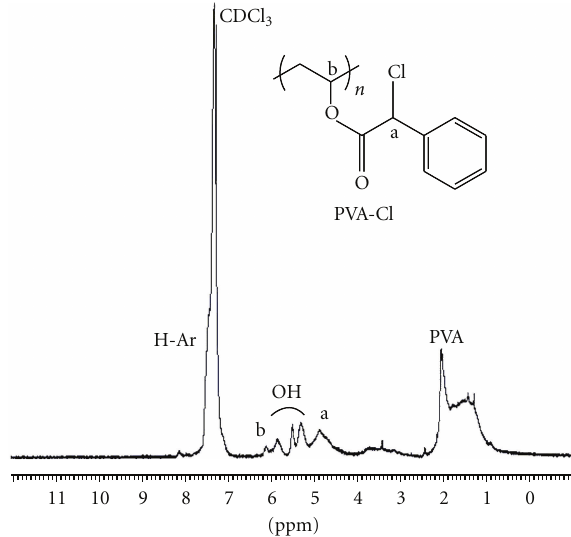
Figure 3: 1 H-NMR spectrum of PVA-Cl.